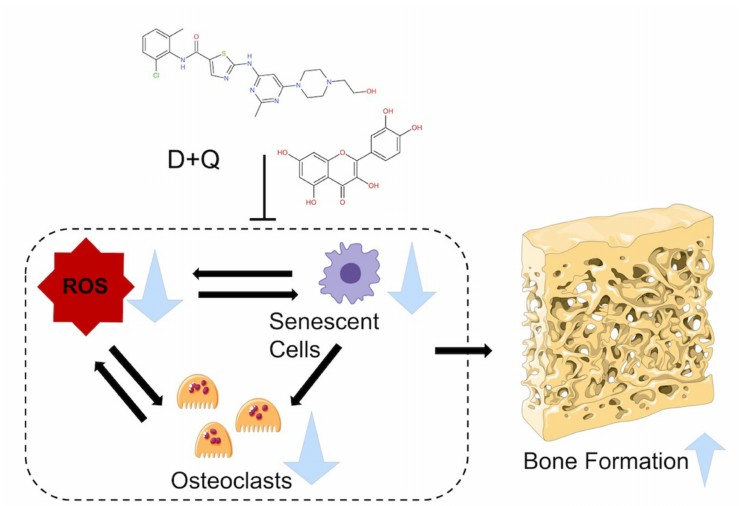
Figure 13. Hypothetical scheme for boosting bone formation ability of beta-tricalcium phosphate ( β -TCP) by senolytic